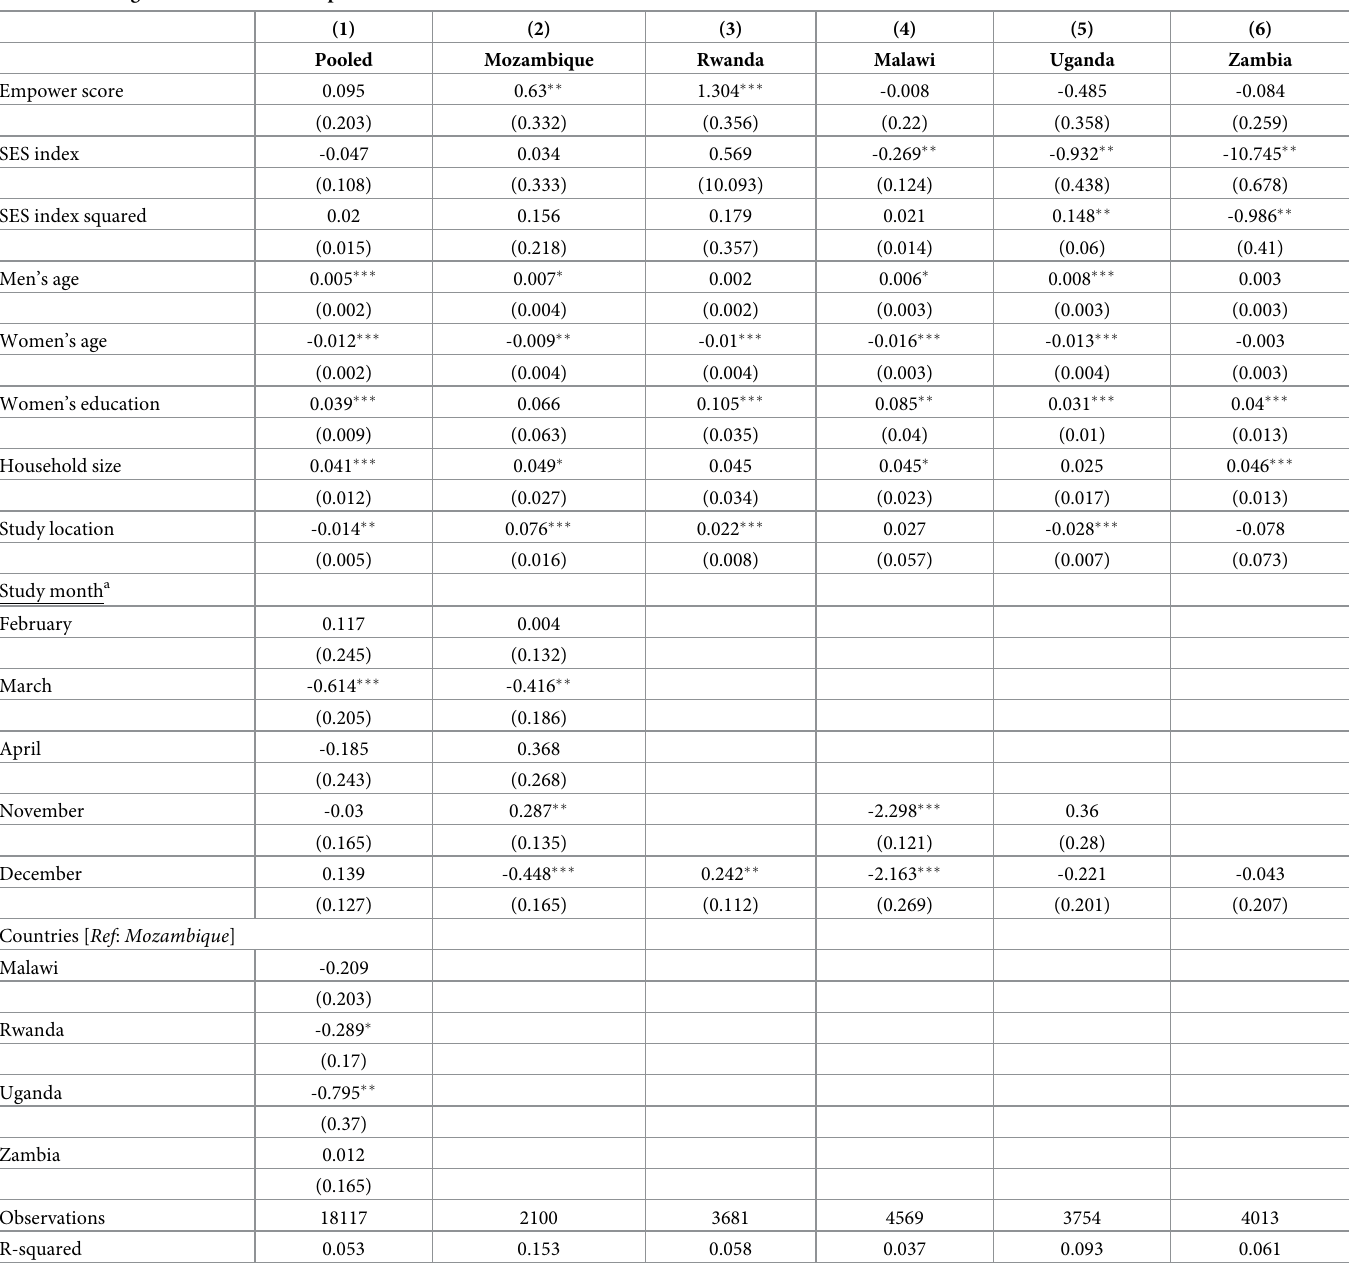
Table 4. OLS regression for WDDS–empowerment